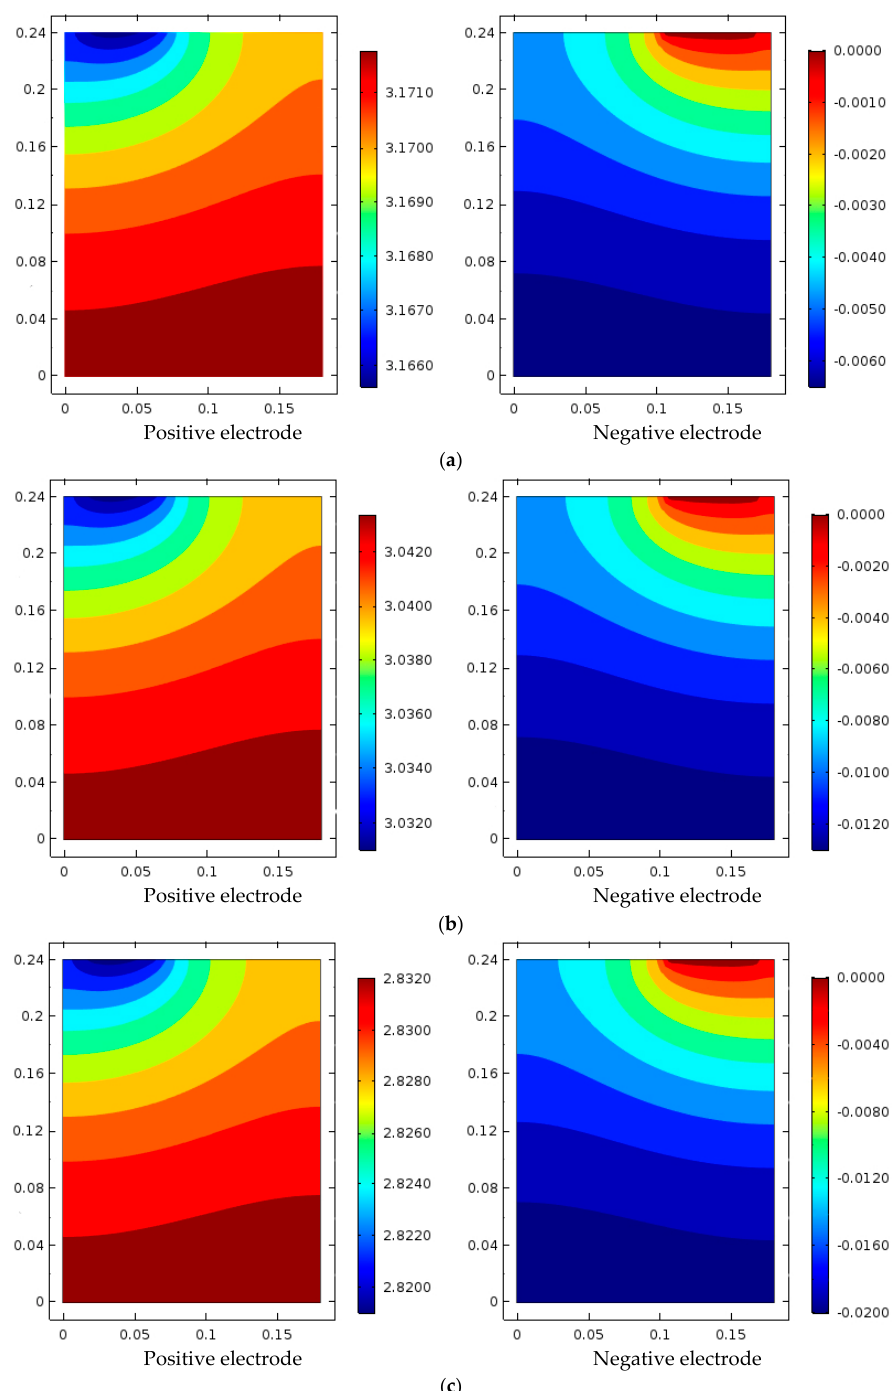
Figure 6. Potential distributions of positive electrode and negative electrode for the discharge rate of ( a ) 1C; ( b ) 2C; ( c ) 3C at the discharging time t = 14